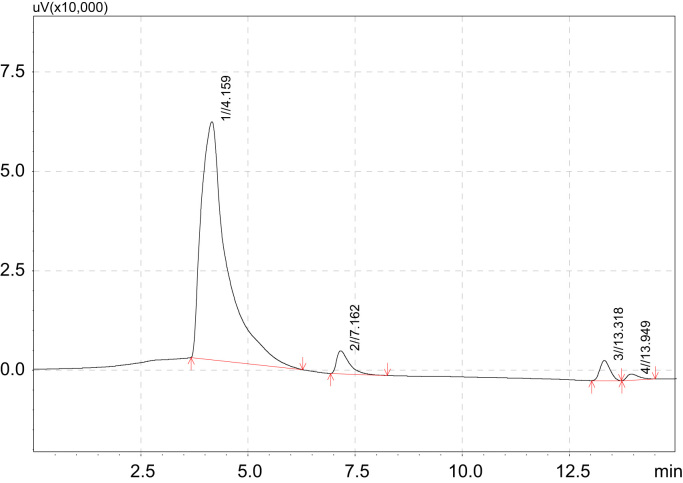
Sample standard.